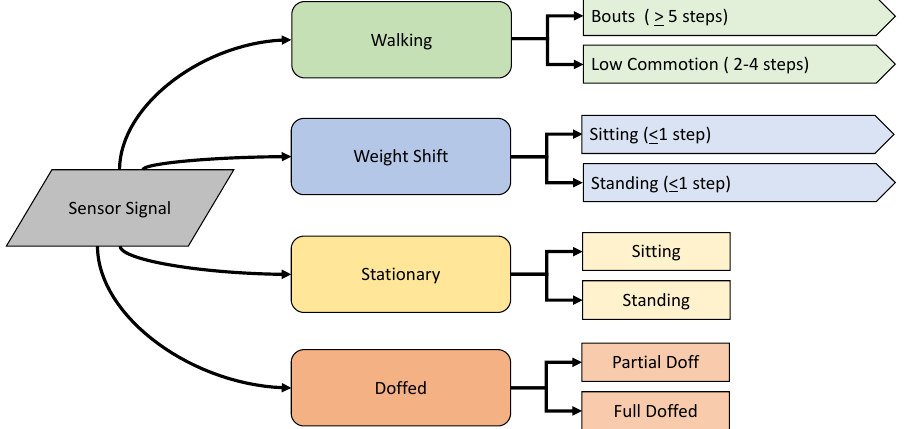
Figure A3. Diagram illustrating the prosthesis use categories and sub-categories. For each participant, durations of the activities were assembled into bar charts for each day and pie charts for the sum duration of all prosthesis days. Steps during walking bouts and low commotion were tabulated for each day and for each hour of the day and plotted as bar graphs.